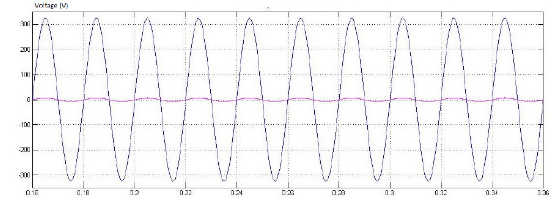
Fig 20: Grid voltage and grid current with FLC